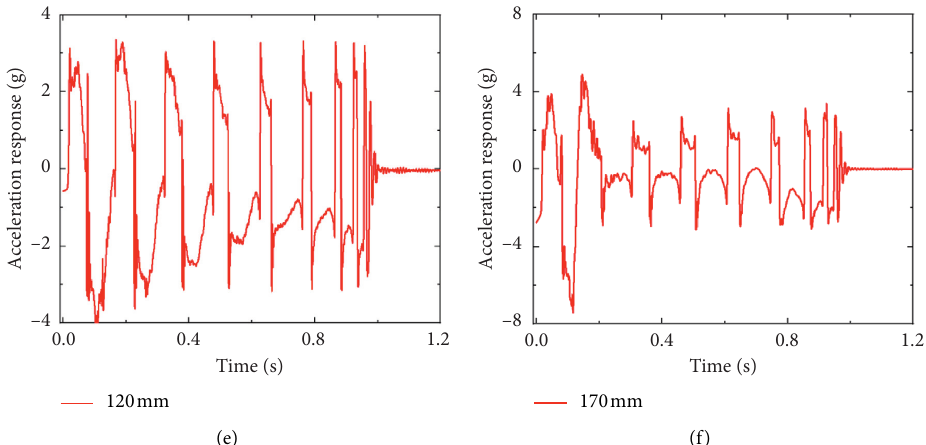
Figure 17: The shock testing results of the NSA under different drop heights. (a) The drop height is 90mm when k � 0.58 N/mm. (b) The drop height is 120 mm when k � 0.58N/mm. (c) The drop height is 170mm when k � 0.58N/mm. (d) The drop height is 90mm when k � 5.15N/mm. (e) The drop height is 120 mm when k � 5.15N/mm. (f) The drop height is 170mm when k � 5.15